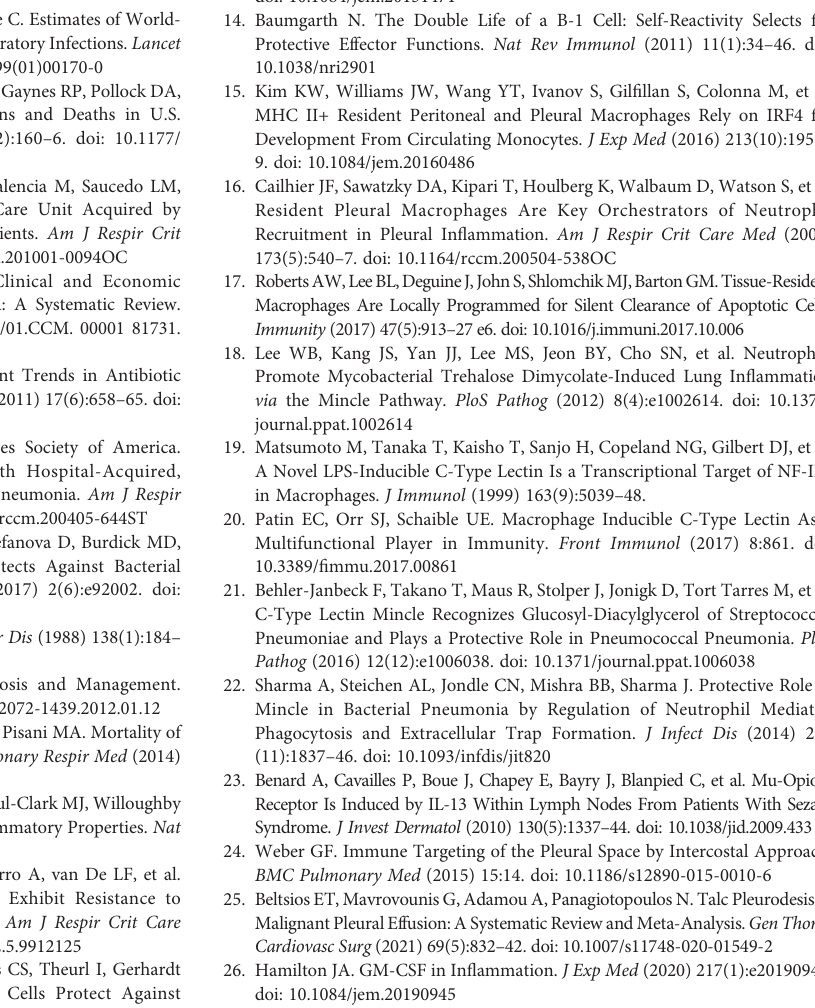
independent experiments. Data represent mean ± S.E.M. and were analyzed by the two-tailed unpaired t-test. *p<0.05; **p<0.01; ***p<0.001. Supplementary Figure 4 | E. coli pneumonia does not induce early apoptotic LRMs.Representative dotplotsand percentageof earlyapoptotic cells(Annexin-V + 7AAD - ) and late apoptotic/necroptotic cells (Annexin-V + 7AAD + ) inside the LRM population in the PS of mice infected or not with E. coli during 24h (n=4). Data are pooled data from at least 2 independent experiments. Data represent mean ± S.E.M. and were analyzed by the two-tailed unpaired t-test. *p<0.05. Supplementary Figure 5 | Stimulation of pleural cells by TDB induces in fl ammation. (A) Relative mRNA expression of Clec4e in PS cells 24h after i.t. injection of PBS or 5x10 6 CFU of E. coli (n=4 mice). (B) MFI of Mincle at the surface of pleural CD11b + F4/80 + macrophages 24h after i.t. injection of PBS or 5x10 6 CFU of E. coli (n= 7 mice). (C) Representative histogram and MFI of Mincle at the surface of pleural neutrophils 24h after i.t. injection of 5x10 6 CFU of E. coli (n= 7 mice). (D) Representative histogram and MFI of phospho-Syk in pleural CD11b + F4/80 + macrophages 30min after ex vivo stimulation with TDB (10µg) (n=3). (E, F) Enumeration of neutrophils (E) and TNF a levels (F) in PS 24h after i.pls. injection of PBS or TDB (50µg) (n=9 mice). (G) Levels of TNF a in culture supernatants of pleural immune cells from WT or Clec4e -/- mice 24h after ex vivo stimulation with TDB (10µg/ml) (n=2-3). (A) The expression level was arbitrarily set to 1 for one sample